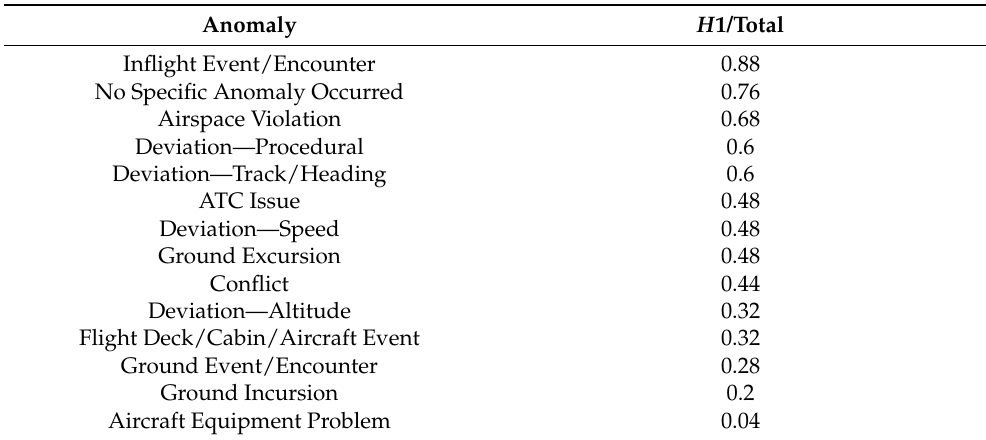
Figure 7. Distributions of the performance scores without overlaps between the two models across the text classification problems. Table 11. Statistical hypothesis testing to study the significance of the performance gap between the two models for each